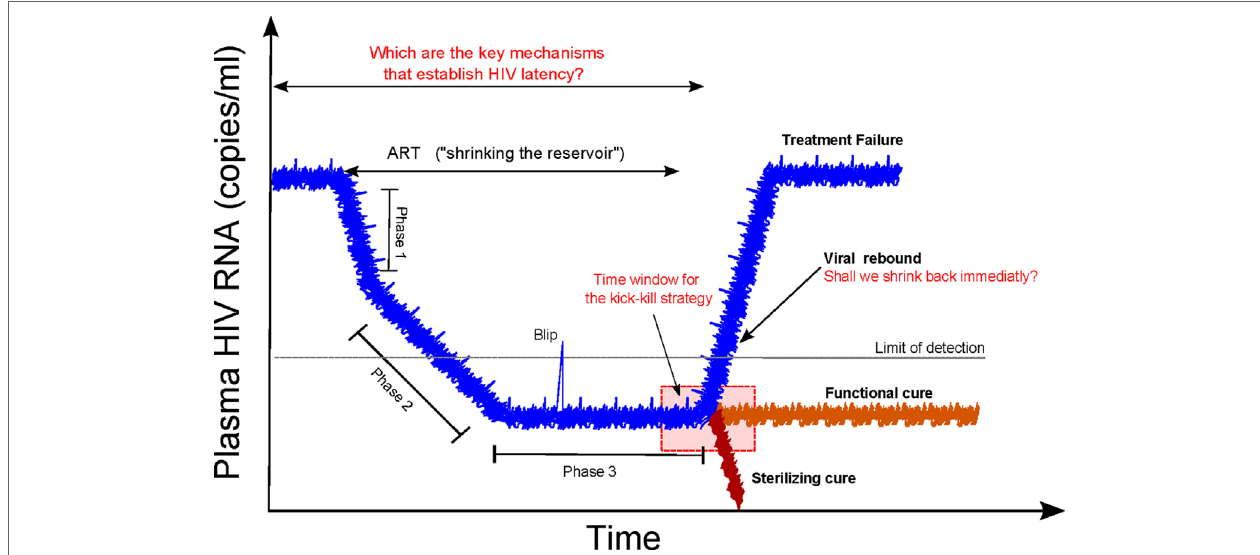
FigURe 1 | Shrink-kick-kill strategies toward an HIV cure. HIV undergoes three phases after cART initiation. The first phase describes the rapid decay of productively infected cells, e.g., activated CD4 + T cells. The second phase is led by cells that possess a half-life of about 14 days, which are not completely identified but are possibly macrophages and dendritic cells. The third phase is a low but stable level of residual viremia giving a plateau phase, which contains occasional viremic episodes (called blips). This third phase has been attributed to long-term reservoirs maintained by activation of latently infected memory CD4 + T cells. Recently, it has been hypothesized that tailoring a kick-kill strategy after cART cessation could lead to a sterilizing cure or a functional cure, i.e., achieving a controlled viremia below detection. This figure is a modification from Ref.